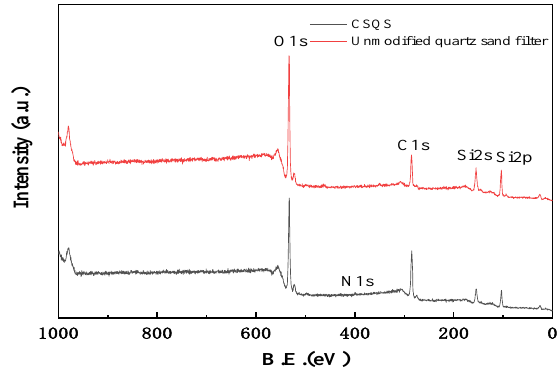
Figure 7. XPS spectra of CSQS.